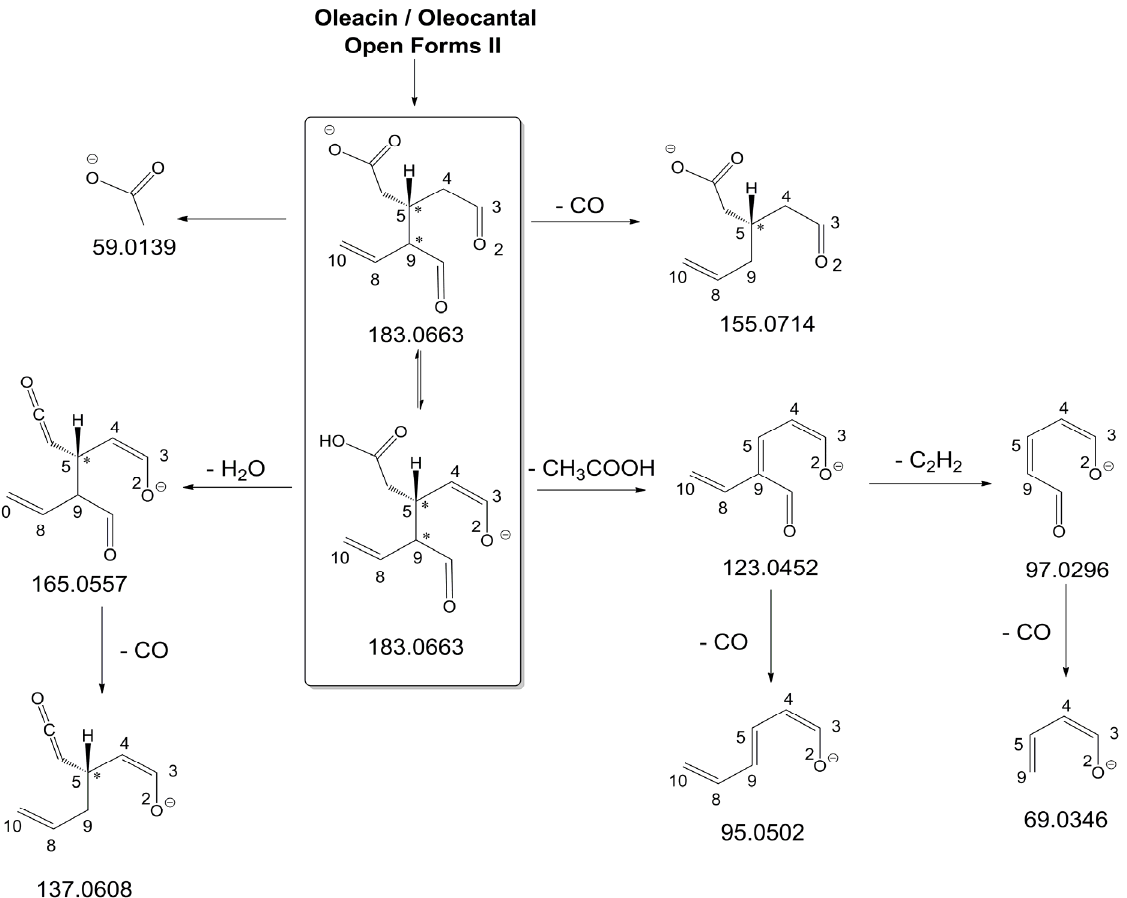
Figure 4. Fragmentation pathways hypothesised to explain the generation of product ions detected in MS/MS spectra referred to oleacin and oleocanthal chromatographic peaks (see Figures 2B and 3B), starting from their common leading product ion, i.e., the anion of decarboxymethyl ‐ elenolic acid (exact m / z 183.0663). Pathways proposed for Open Forms II hypothesised for the two secoiridoids (see Figure 1) are shown (see Figure S1 in the Supplementary Material for those proposed for Open Forms I and Closed Forms I ). The chiral center on C5 and the stereogenic center on C9 are marked by an asterisk.